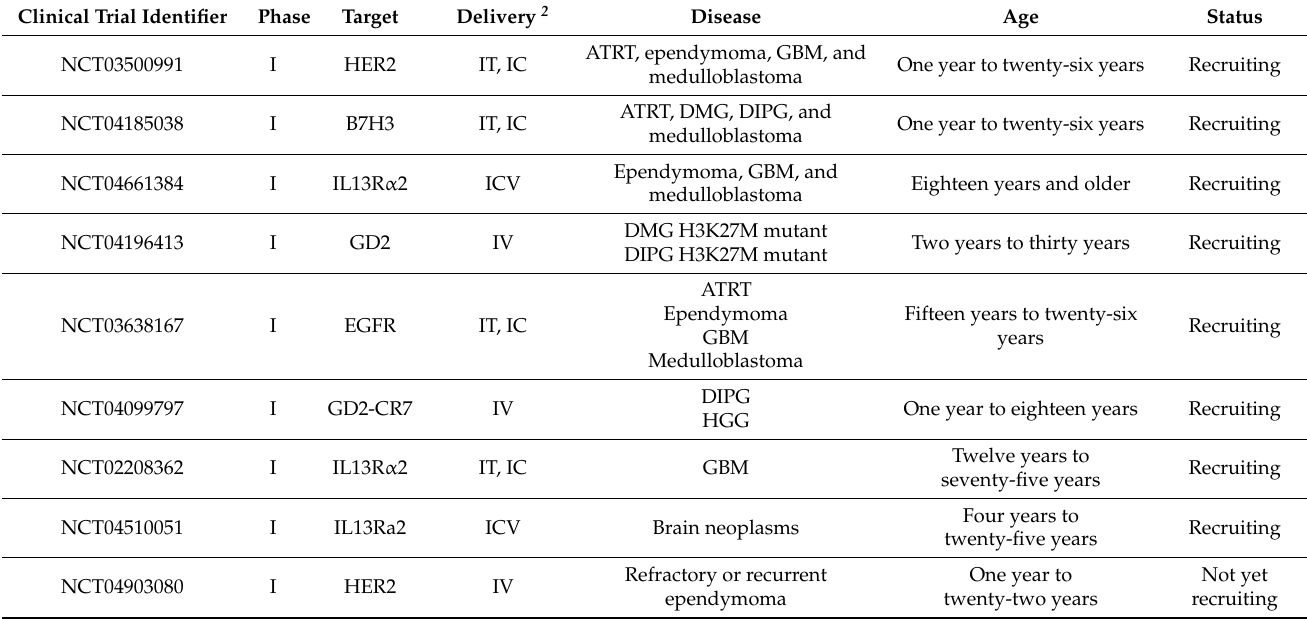
Table 2. Ongoing clinical trials with CAR T cell therapy for pediatric brain tumors 1